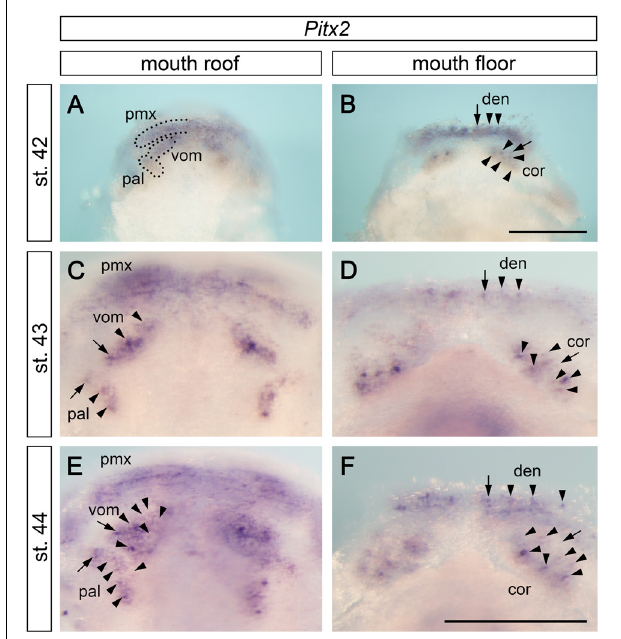
FIGURE 3 | Expression pattern of Pitx2 at later stages of axolotl odontogenesis. Pitx2 expression becomes gradually restricted to individual tooth germs (arrows mark initiator-tooth germs of respective tooth fields and arrowheads mark sequentially added tooth germs). (A,C,E) Within the mouth roof epithelium, the initial Pitx2 expression delineating individual tooth fields (black broken lines in A ) becomes focused into individual tooth germs, inter-germ regions, and the forming successional dental laminae of vomerine (vom) and palatine (pal) tooth fields (C,E) . Pitx2 expression is further associated with the developing premaxillary tooth field (pmx), although individual tooth germs cannot be discerned. (B,D,F) Within the mouth floor epithelium, strong Pitx2 expression is visible in the developing tooth germs of dentary (den) and coronoid (cor) tooth fields. cor, coronoid tooth field; den, dentary tooth field; pal, palatine tooth field; pmx, premaxillary tooth field; vom, vomerine tooth field. Scale bars equal 500 µ m (scale bar in B is valid for A,B , scale bar in F is valid for C–F